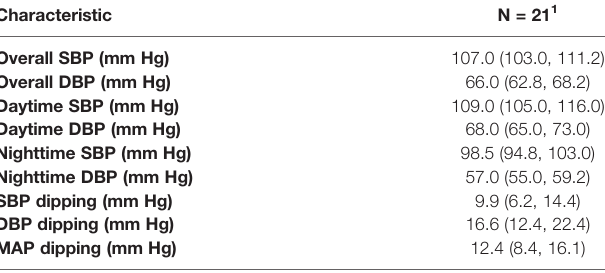
TABLE 3 | Ambulatory blood pressure monitoring data for the study cases. Characteristic